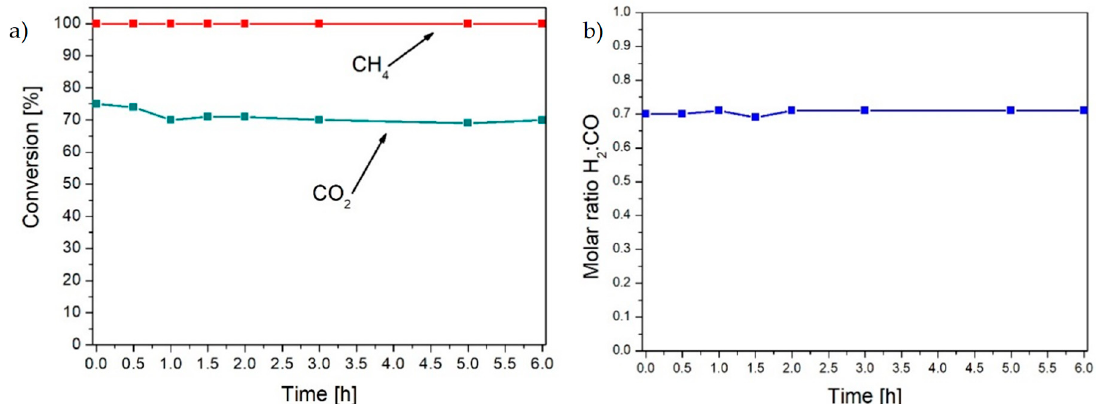
Figure 4. ( a ) Methane and carbon dioxide conversion and ( b ) hydrogen/carbon monoxide molar ratio for the 6 h test.